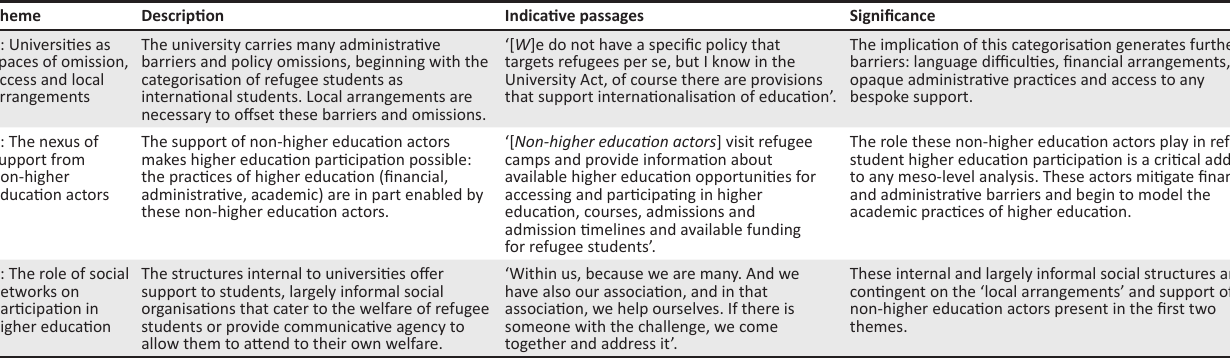
TABLE 1: A summary of themes impacting the lifeworlds of refugee